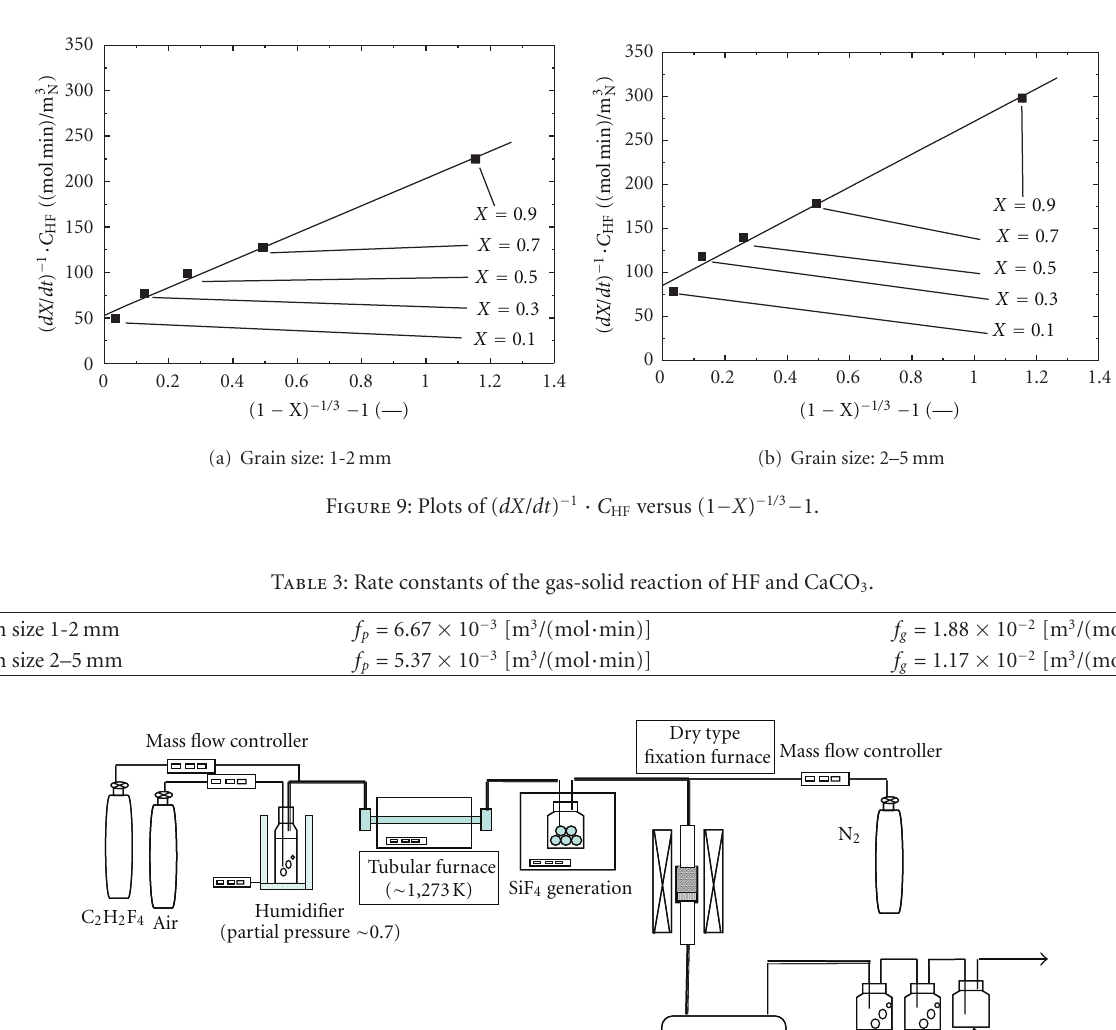
Figure 8: Reaction rate of CaCO 3 plotted against the HF concentration.